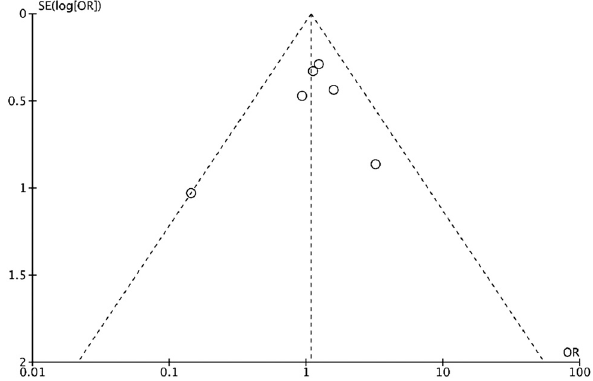
Figure 5: Funnel plot of postoperative overall complications in the included studies showing no evidence of publication bias. SE: standard error, OR: odds